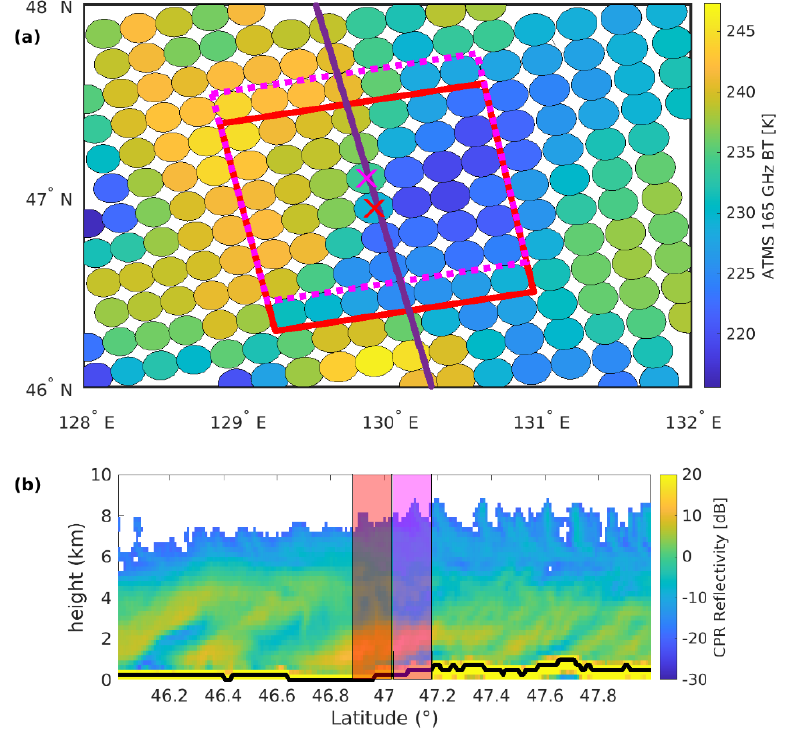
Figure 1. Coincidence dataset schematics. All data represented in the figure are from a snowfall case study occurring over northern China on 11 March 2015 (CPR orbit number 47170). On the top panel ( a ), the purple line represents the CPR swath, the red and pink boxes are two subsequent 7 × 7 matrices of collocated ATMS BTs, and the ellipses represent ATMS BTs at 165 GHz. The bottom panel ( b ) shows the corresponding vertical profile of the CPR reflectivity with the two ATMS pixels considered, corresponding to the red and pink “X” in the top panel.